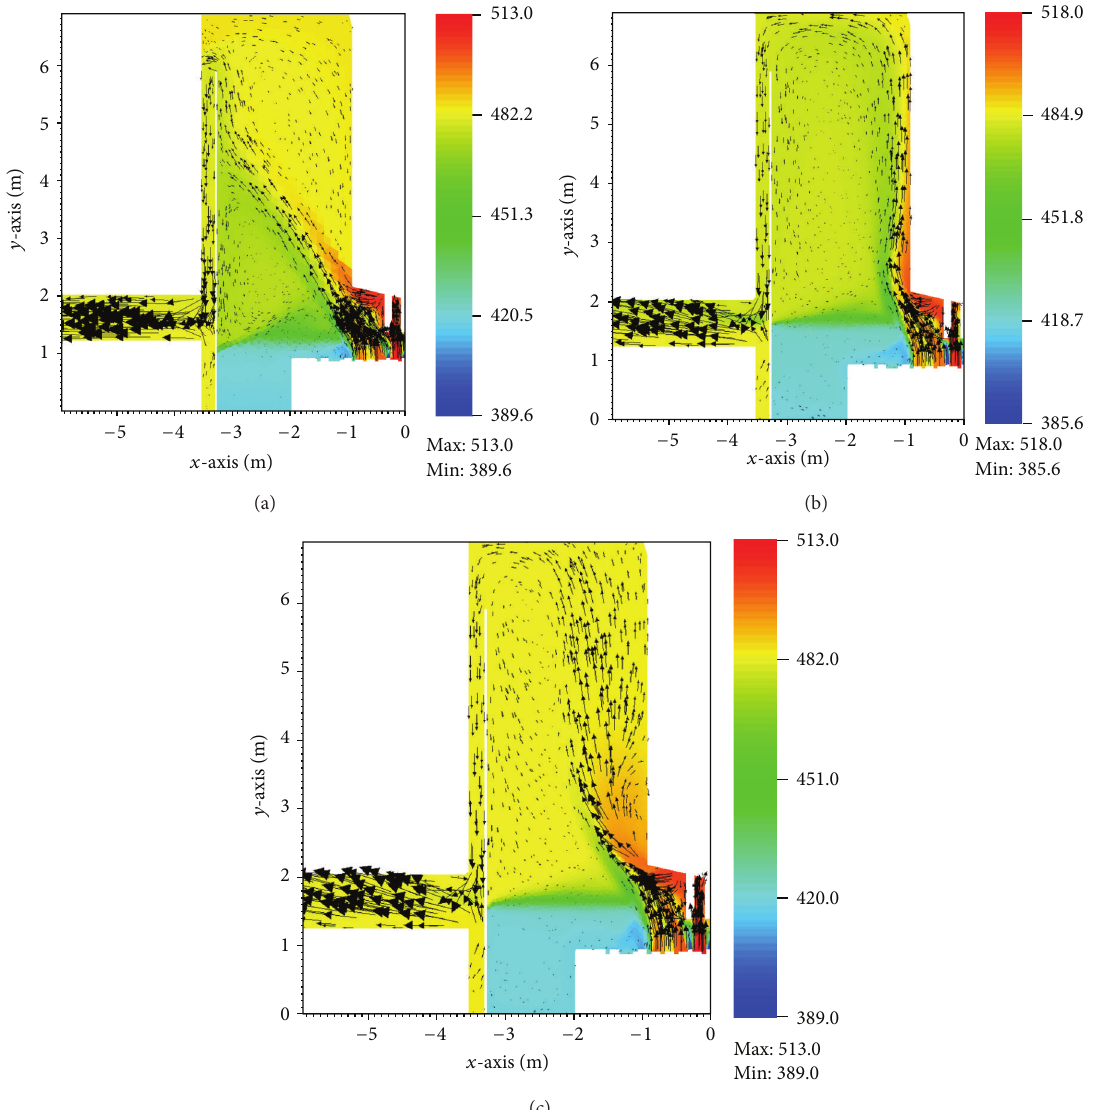
Figure 5: (a) Momentum dominated solution (S 1